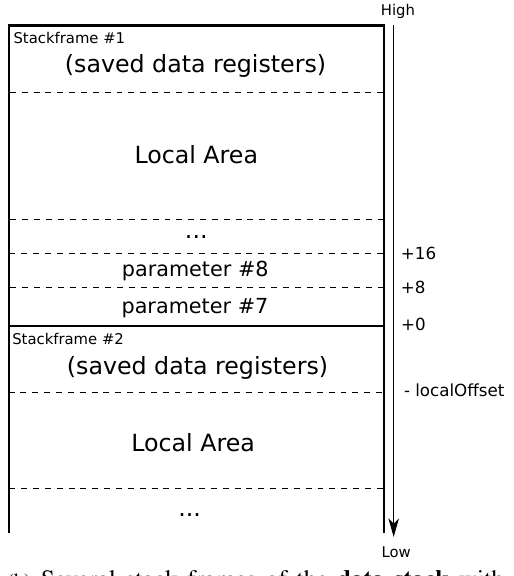
Figure 3. Detailed representation of the unified stack in comparison to the data stack (using the AMD64 calling